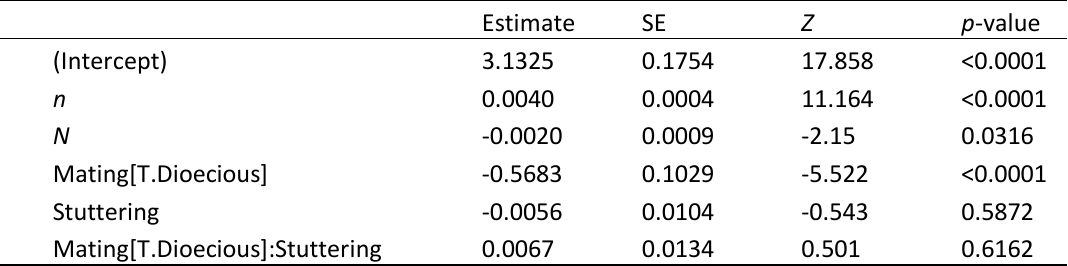
Table 3: Summary of the generalized linear mixed model for the number of locus pairs found with a significant linkage disequilibrium. Explanatory variables were: n (number of subpopulations), N (subpopulation size), mating system (dioecious pangamy or monoecy with 30% selfing) and stuttering intensity (0 or 10%). In case of qualitative variables (mating system), the modalities with least positive effects are compared to the one with the most positive effect (not shown in the output of the